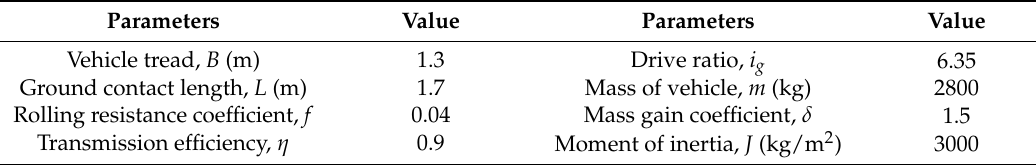
Table 1. Vehicle